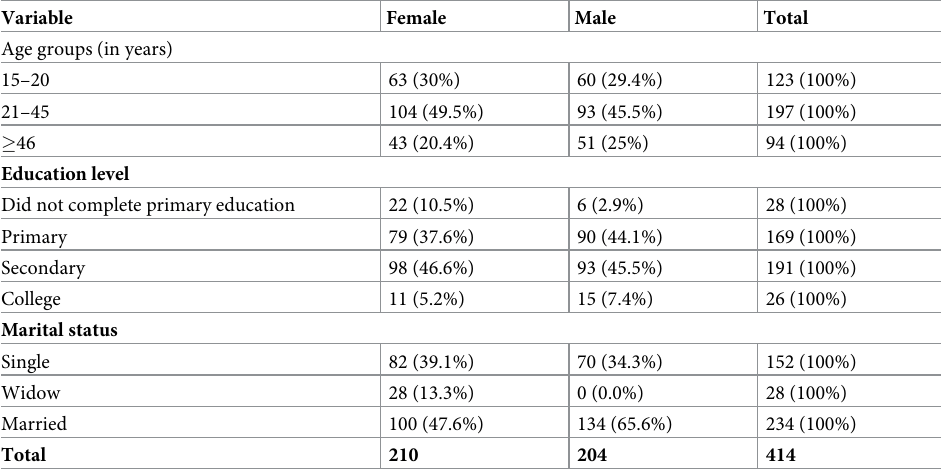
Table 3. Demographic characteristics of the study participants Variable Female